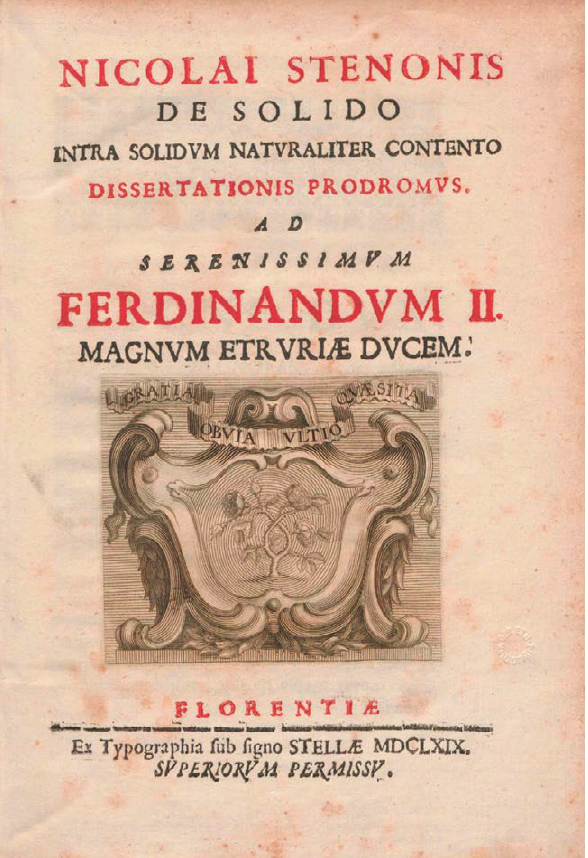
Fig. 6. Title page of Steno’s Prodromus (Florentia: Ex typographiae sub signo Stellae,